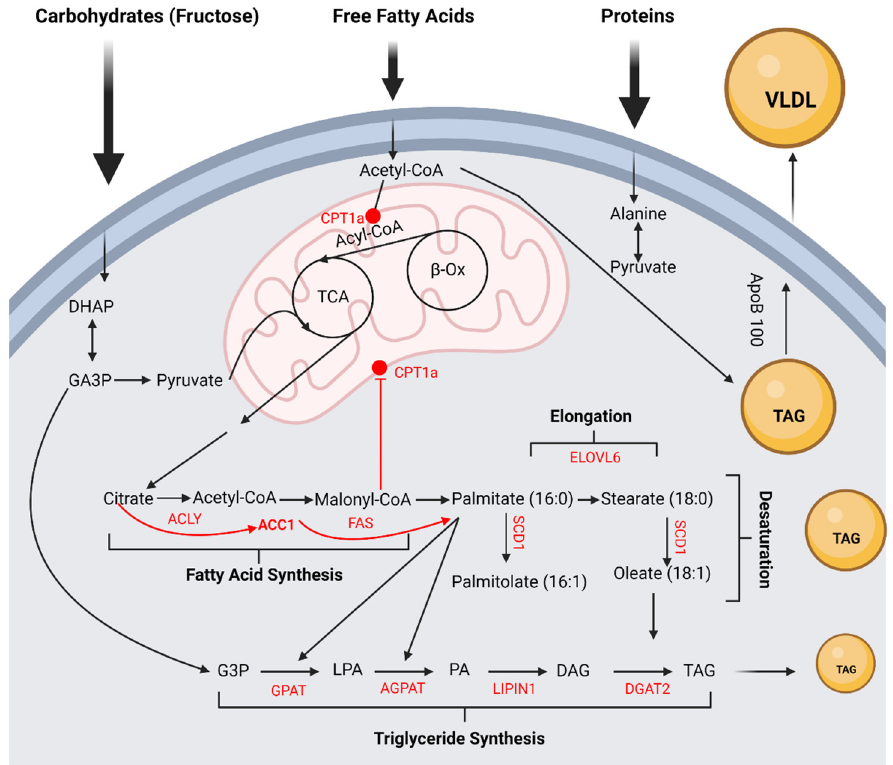
Figure 2. Fructose and Hepatic De Novo Lipogenesis. Fructose intake can initiate de novo lipogenesis quickly through the following pathways: (1) via entrance into glycolysis as glyceraldehyde ‐ 3 ‐ phosphate (Glyc ‐ 3 ‐ P or GA3P) via the unregulated accumulation of intermediates dihydroxyacetone phosphate (DHAP) and/or glyceraldehyde thereby, increasing the production of acetyl ‐ CoA, and (2) via the more direct entrance of lipogeneses as glycerol ‐ 3 ‐ phosphate (G ‐ 3 ‐ P) via the unregulated accumulation of intermediate DHAP. In the presence of excess acetyl ‐ CoA, following fructose intake, in the tricarboxylic acid (TCA) cycle, TCA intermediates accumulate and release citrate into the cytoplasm. Citrate is converted by ATP ‐ citrate lyase (ACLY) to acetyl ‐ CoA. Additionally, citrate is an allosteric activator of acetyl ‐ Co ‐ A carboxylase (ACC), which converts acetyl ‐ CoA to malonyl ‐ CoA. Fatty acid synthase (FAS), a biosynthetic enzyme, uses malonyl ‐ CoA as a substrate to produce palmitate (C16:0), the first fatty acid product. Palmitate (C16:0) can be elongated to fatty acid stearate (18:0) or longer fatty acids by enzyme elongation of very long chain fatty acid protein 6 (ELOVL6). The saturated fatty acids, palmitate (C16:0) and stearate (18:0), are desaturated by stearoyl ‐ CoA desaturase (SCD1) to become monounsaturated fatty acids palmitolate (16:1) and oleate (18:1). Following desaturation, monounsaturated fatty acids may be esterified to the glycerophosphate backbone of G ‐ 3 ‐ P to produce the following additional complex lipids: fatty acids, such as stearic acid, palmitoleic acid and oleic acid, and TAG. Fatty acid acyl ‐ Co ‐ As are added to G ‐ 3 ‐ P by glycerol ‐ 3 ‐ phosphate acyltransferase (GPAT) to produce lysophosphatidic acid (LPA). 1 ‐